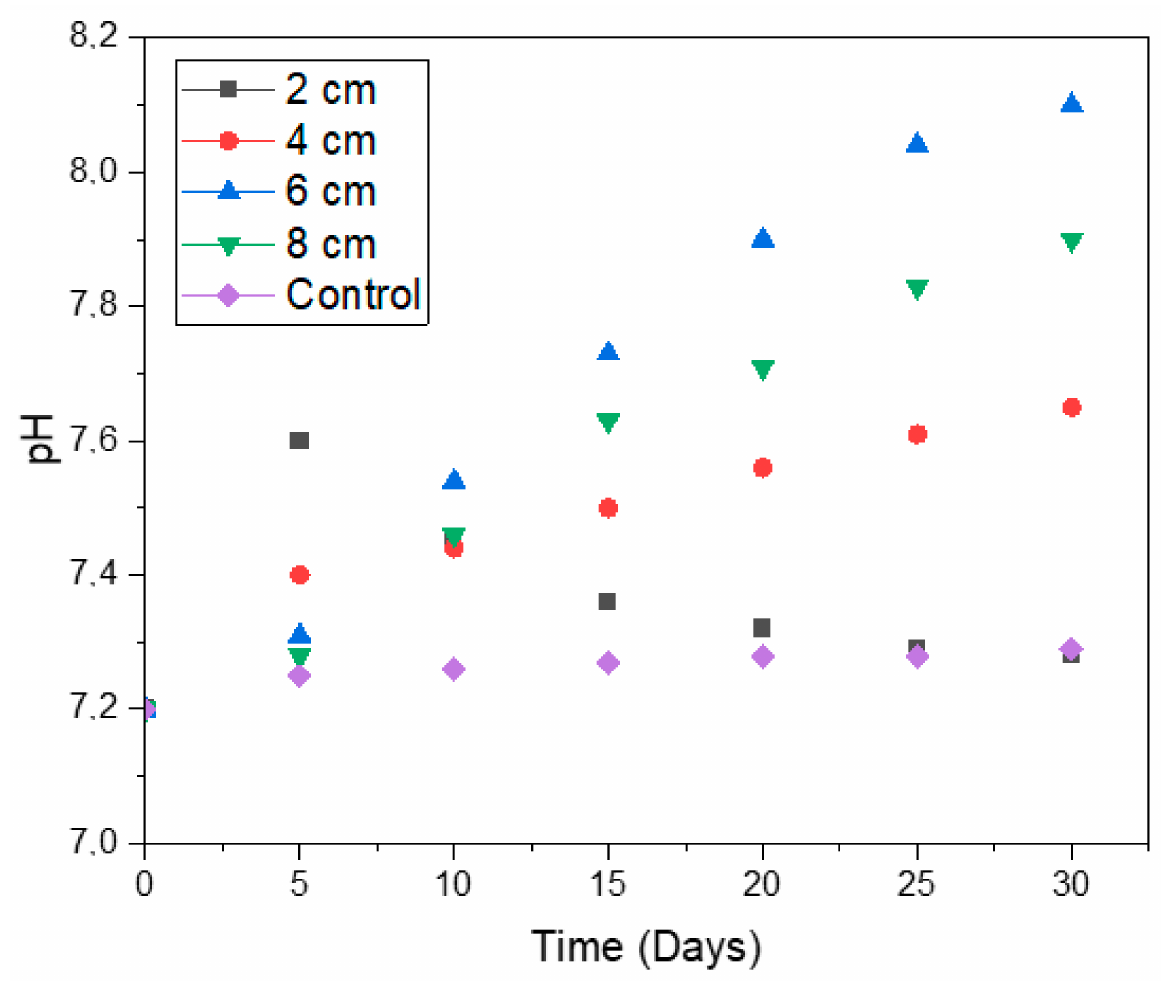
Figure 9. The pH of the digesters with respect to time. The average pH values for electrode spacings of 2, 4, 8, and 6 cm were 7.35, 7.48, 7.57, and 7.69, whereas the average power densities for biogas accumulation were 5.51, 5.88, 5.99, and 11.56 mW/m 2 , respectively. Thus, the higher the pH, the higher the power density; the digester with the highest pH of 7.69 (i.e., electrode spacing of 6 cm) generated the highest average power density of 11.56 mW/m 2